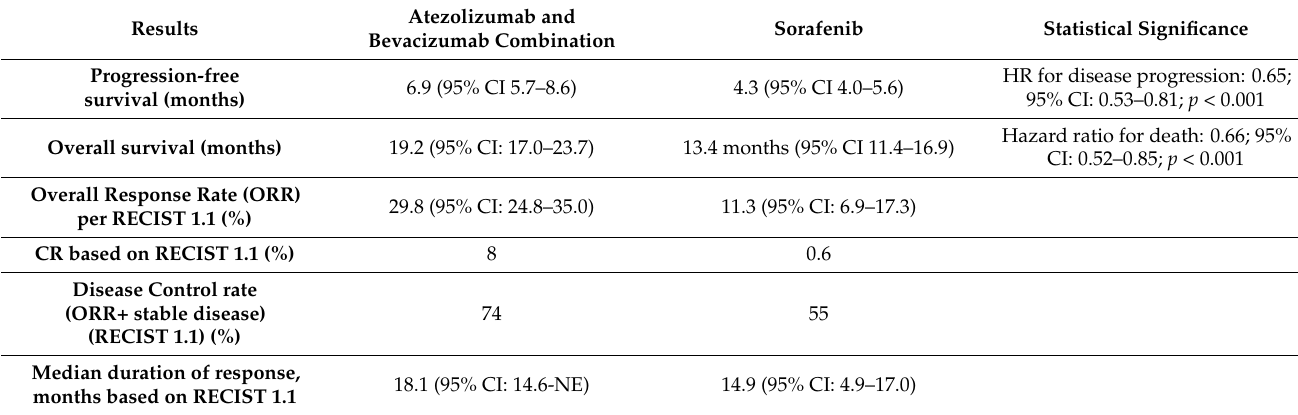
Table 3. Primary and secondary efficacy outcomes in IMbrave 150 trial